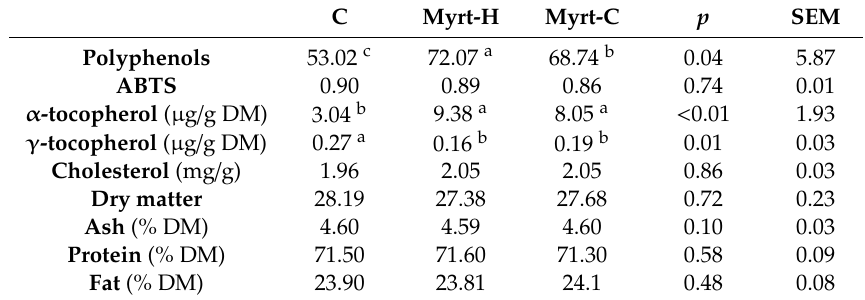
Table 1. Antioxidant activity and chemical composition (% DM) of meat from ewes fed myrtle residues.